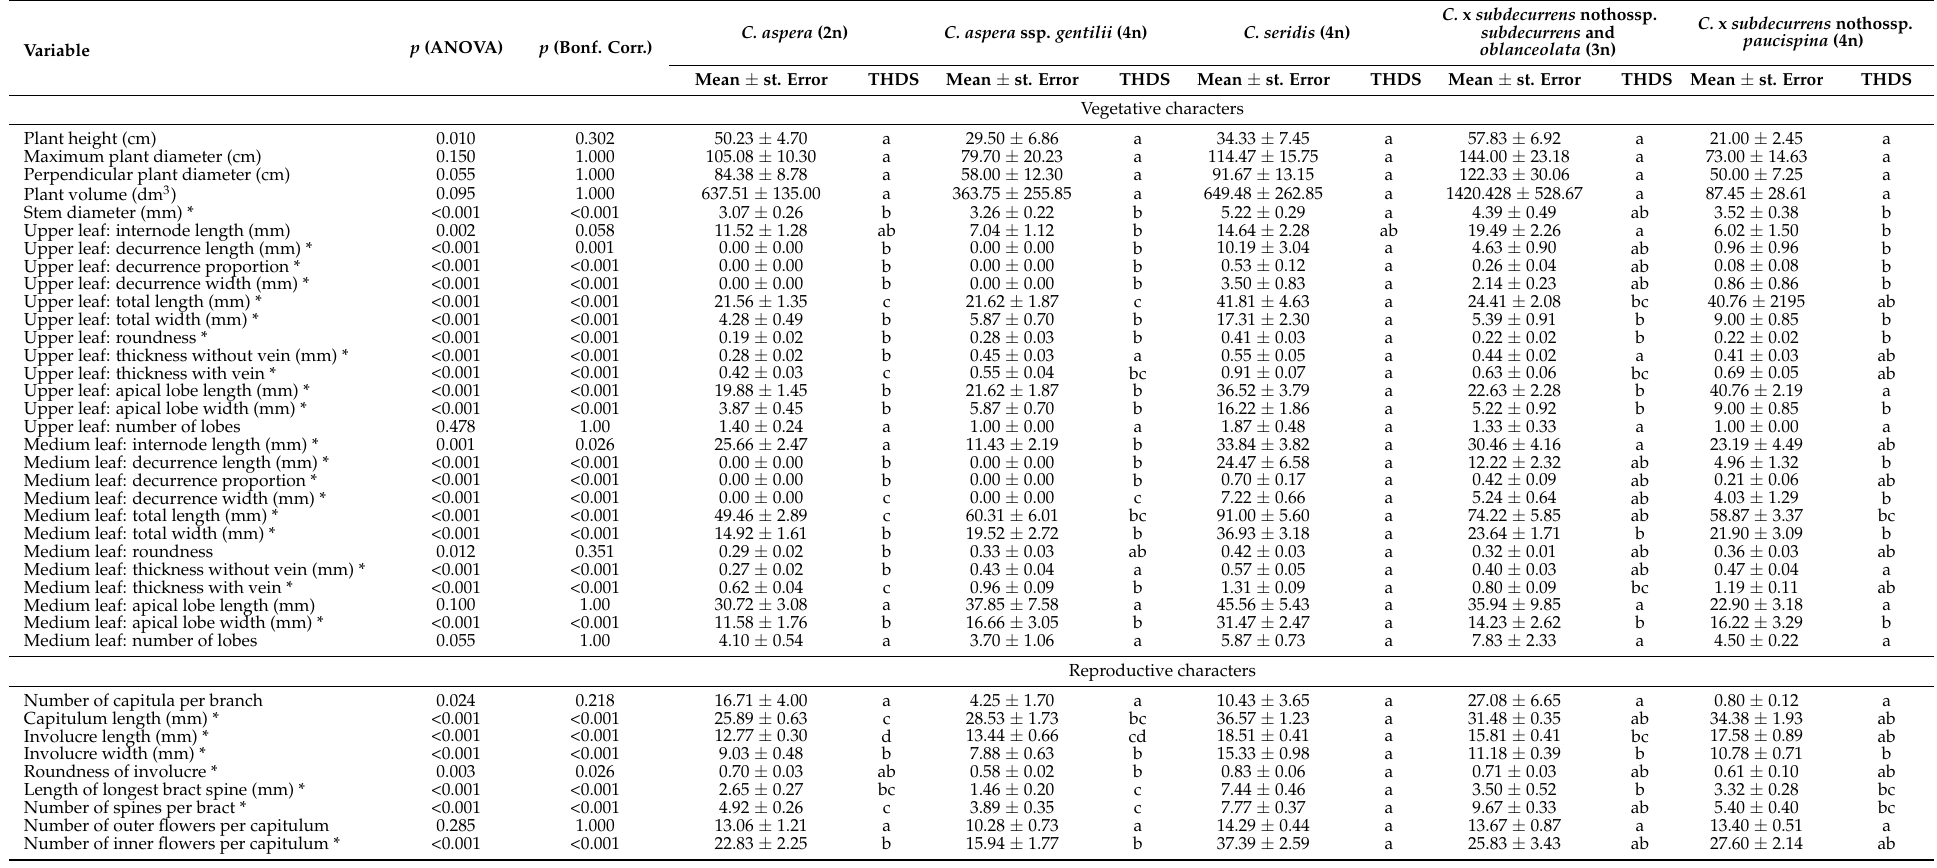
Table 3. ANOVAs of the morphological characters among the Centaurea clusters obtained using STRUCTURE (twenty-six diploid C. aspera individuals, ten tetraploid C. aspera ssp. gentilii , fifteen tetraploid C. seridis , six triploid C. x subdecurrens (nothossp. subdecurrens and nothossp. oblanceolata ), and five tetraploid C. x subdecurrens nothossp. paucispina individuals). Bonferroni correction, mean and standard error are indicated. Different letters indicate differences among clusters resulting from post hoc Tukey HSD tests (THDS). *: variables used for